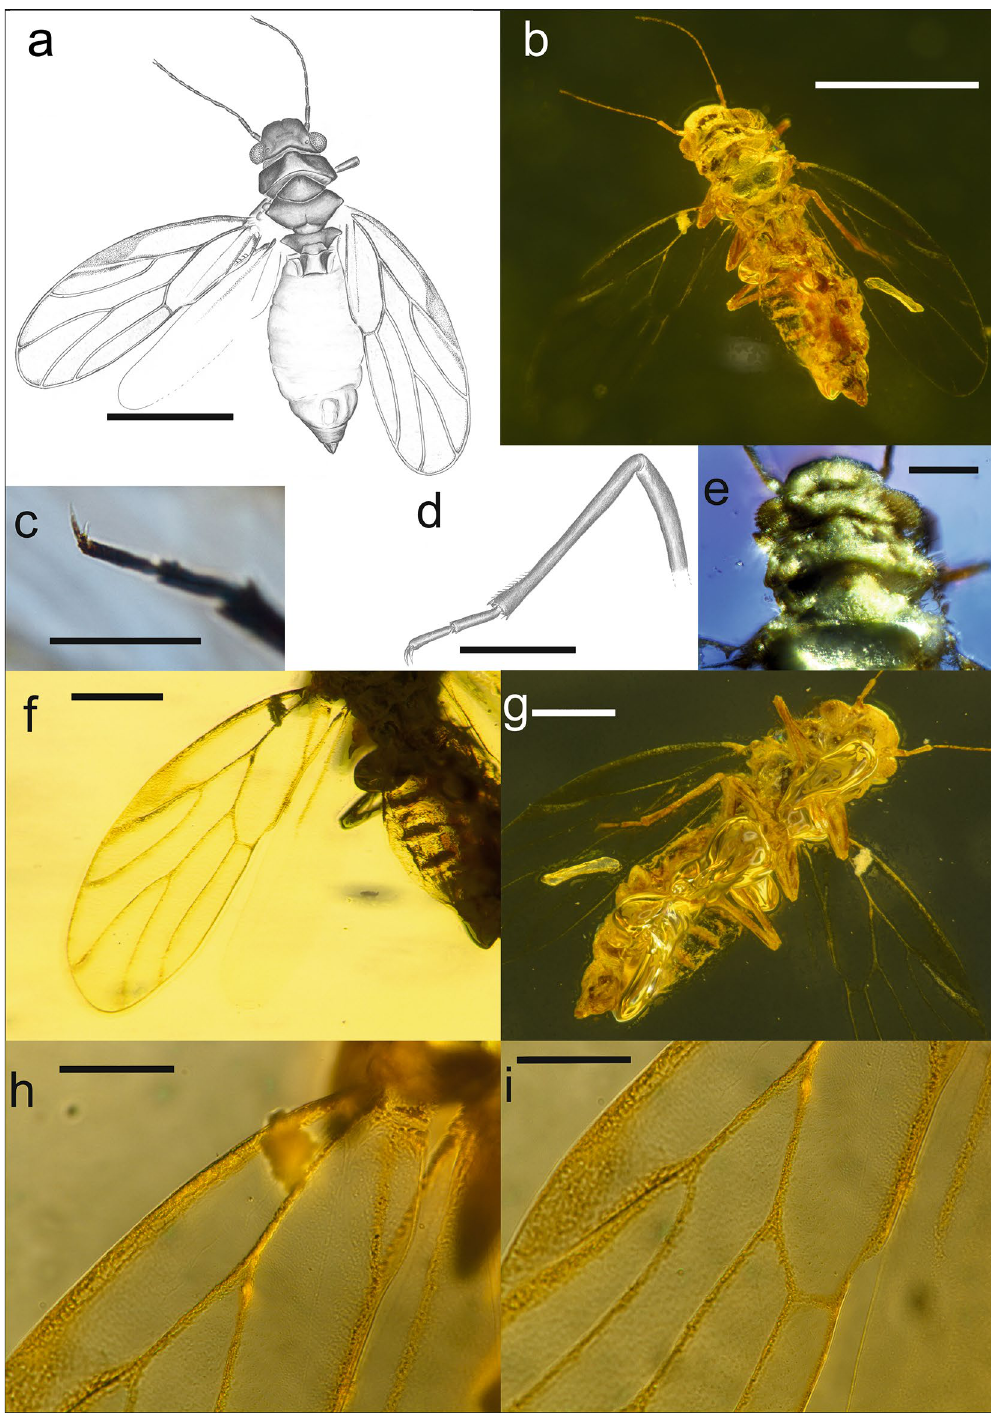
Figure 2. ( a ‒ i ) Amecephala pusilla gen. et sp. nov. imago. Drawing of body in dorsal view ( a ), Body in dorsal view ( b ), Metatarsus ( c ), Drawing of hind leg ( d ), Head in dorsal view ( e ), Forewing ( f ), Body in ventral view ( g ), Basal part of claval suture ( h ), Distal part of claval suture ( i ); Scale bars: 0.5 mm ( a , b ); 0.2 mm ( f , g ); 0.1 mm ( c , d , e , h , i